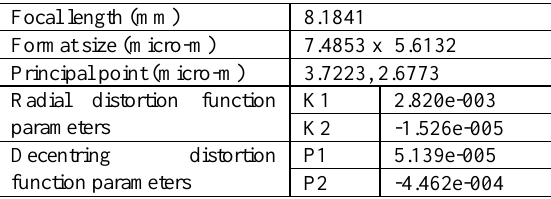
Table 1. Pentax Optio A40 calibration report All photos of the photogrammetric project were resampled using the distortion functions obtained with the pre-calibration.